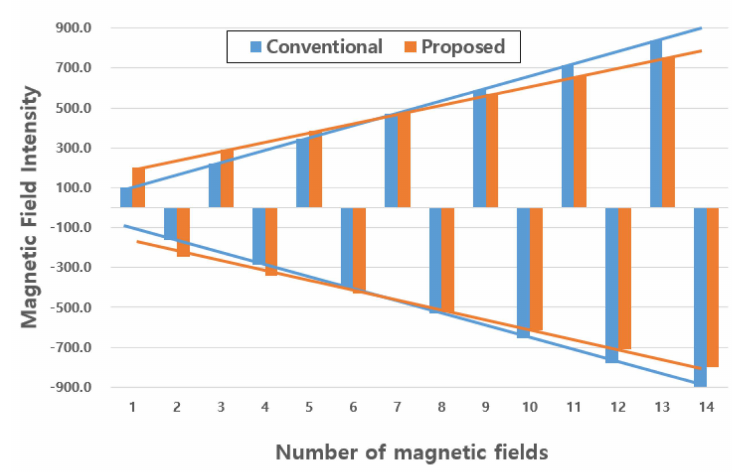
Figure 16. Conventional protocol and proposed protocol in Stage 2.